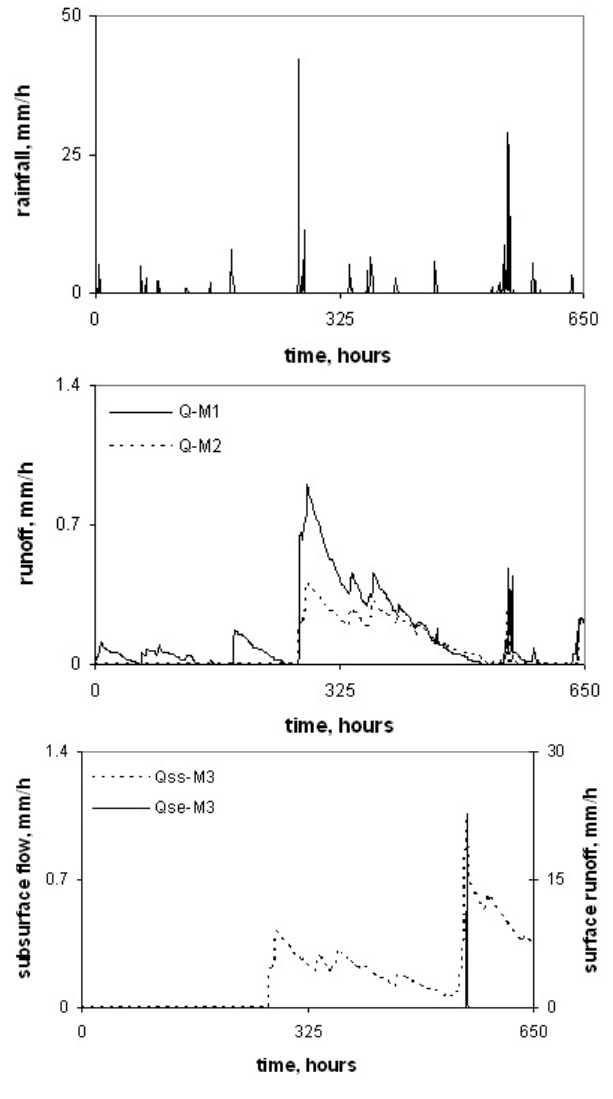
Fig. 3. Schematic representation of rainfall and corresponding runoff generated by Models 1, 2 and 3 (M1, M2, M3) using η =0.5.